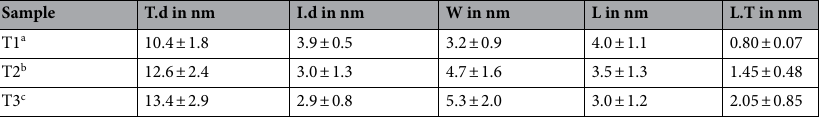
Table 1. Dimensions of samples T1, T2, and T3 in nm. Total diameter (T.d), inner diameter (I.d), layers (L), and layer thickness (L.T). a–c Amount of nanostructures tested: a. 9 NTs; b. 67 NTs; c.43 NTs.